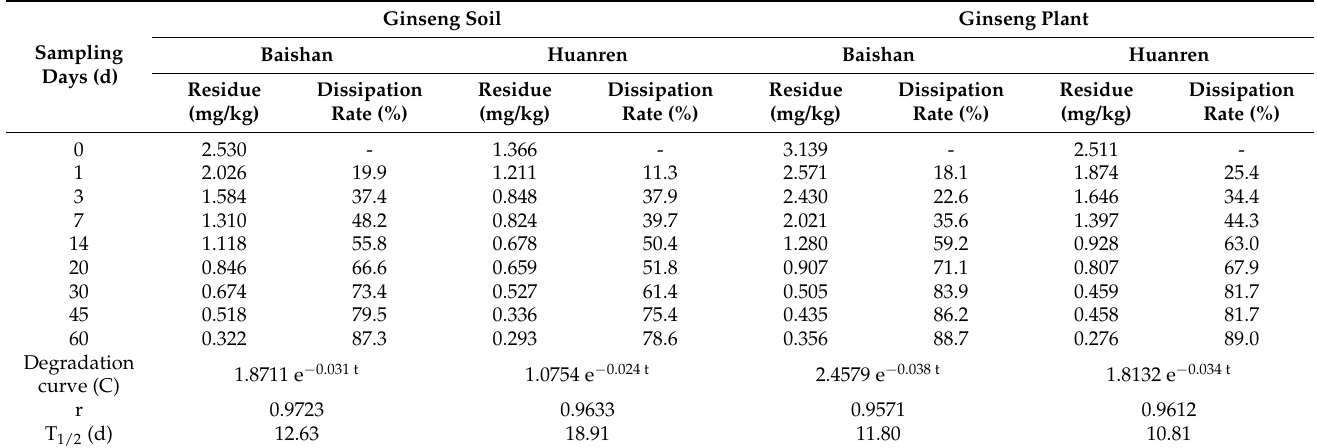
Table 1. Degradation dynamics of butralin.